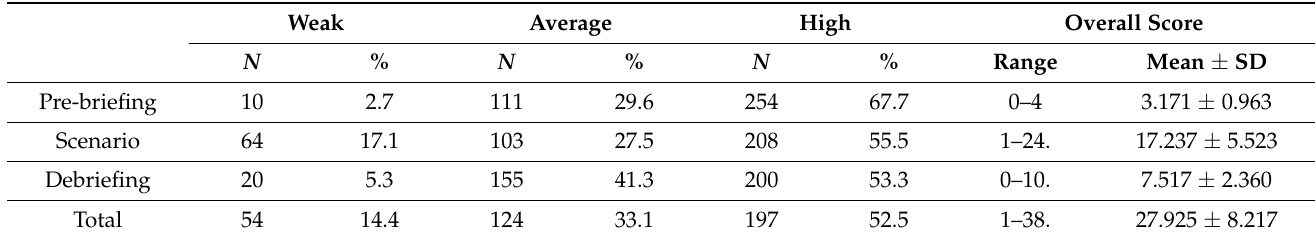
Table 3. Distribution of the level of all domains in study group ( n = 375).